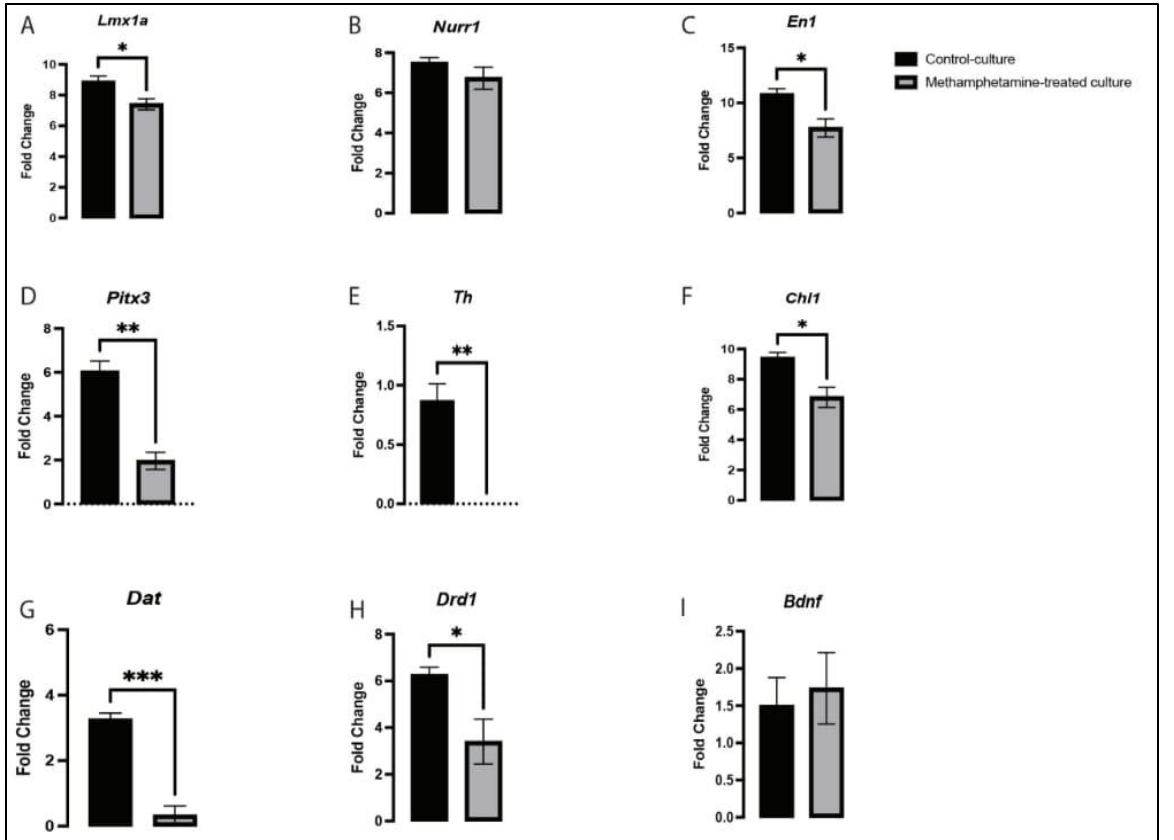
Figure 5. Effects of methamphetamine exposure on the expression of Lmx1a ( A ), Nurr1 ( B ), En1 ( C ), Pitx3 ( D ), Th ( E ), Chl1 ( F ), Dat ( G ), Drd1 ( H ), and Bdnf ( I ). Data are represented as mean ± SEM; n = three technical replicates and four biological replicates; * p < 0.05, ** p < 0.01 and *** p < 0.001. Data were analyzed using a t -test.